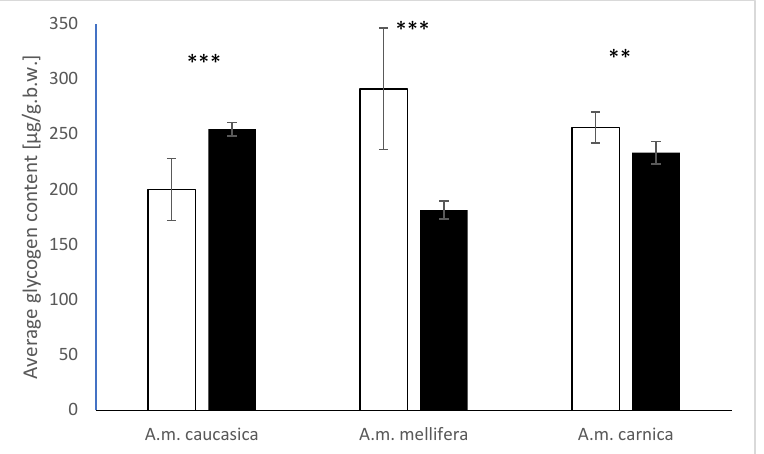
Figure 4. Mean glycogen content (in μg/g.b.w.) in the organisms of worker bees of the subspecies studied in autumn (white bars) and spring (black bars). Statistical significance was determined (** p < 0.01; *** p < 0.001).